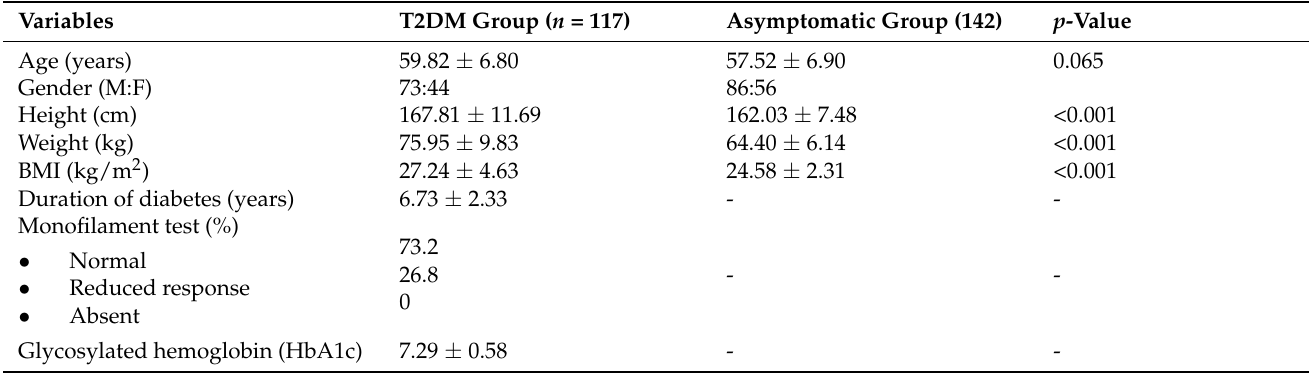
in Table 1. Table 1. Demographic characteristics of the study Table 1. Demographic characteristics of the study population.